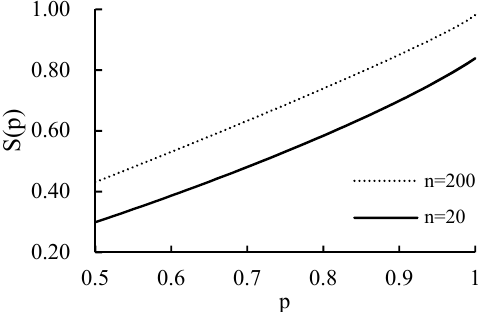
Figure 5. Changes of Wilson score with initial support rate under two sample sizes.